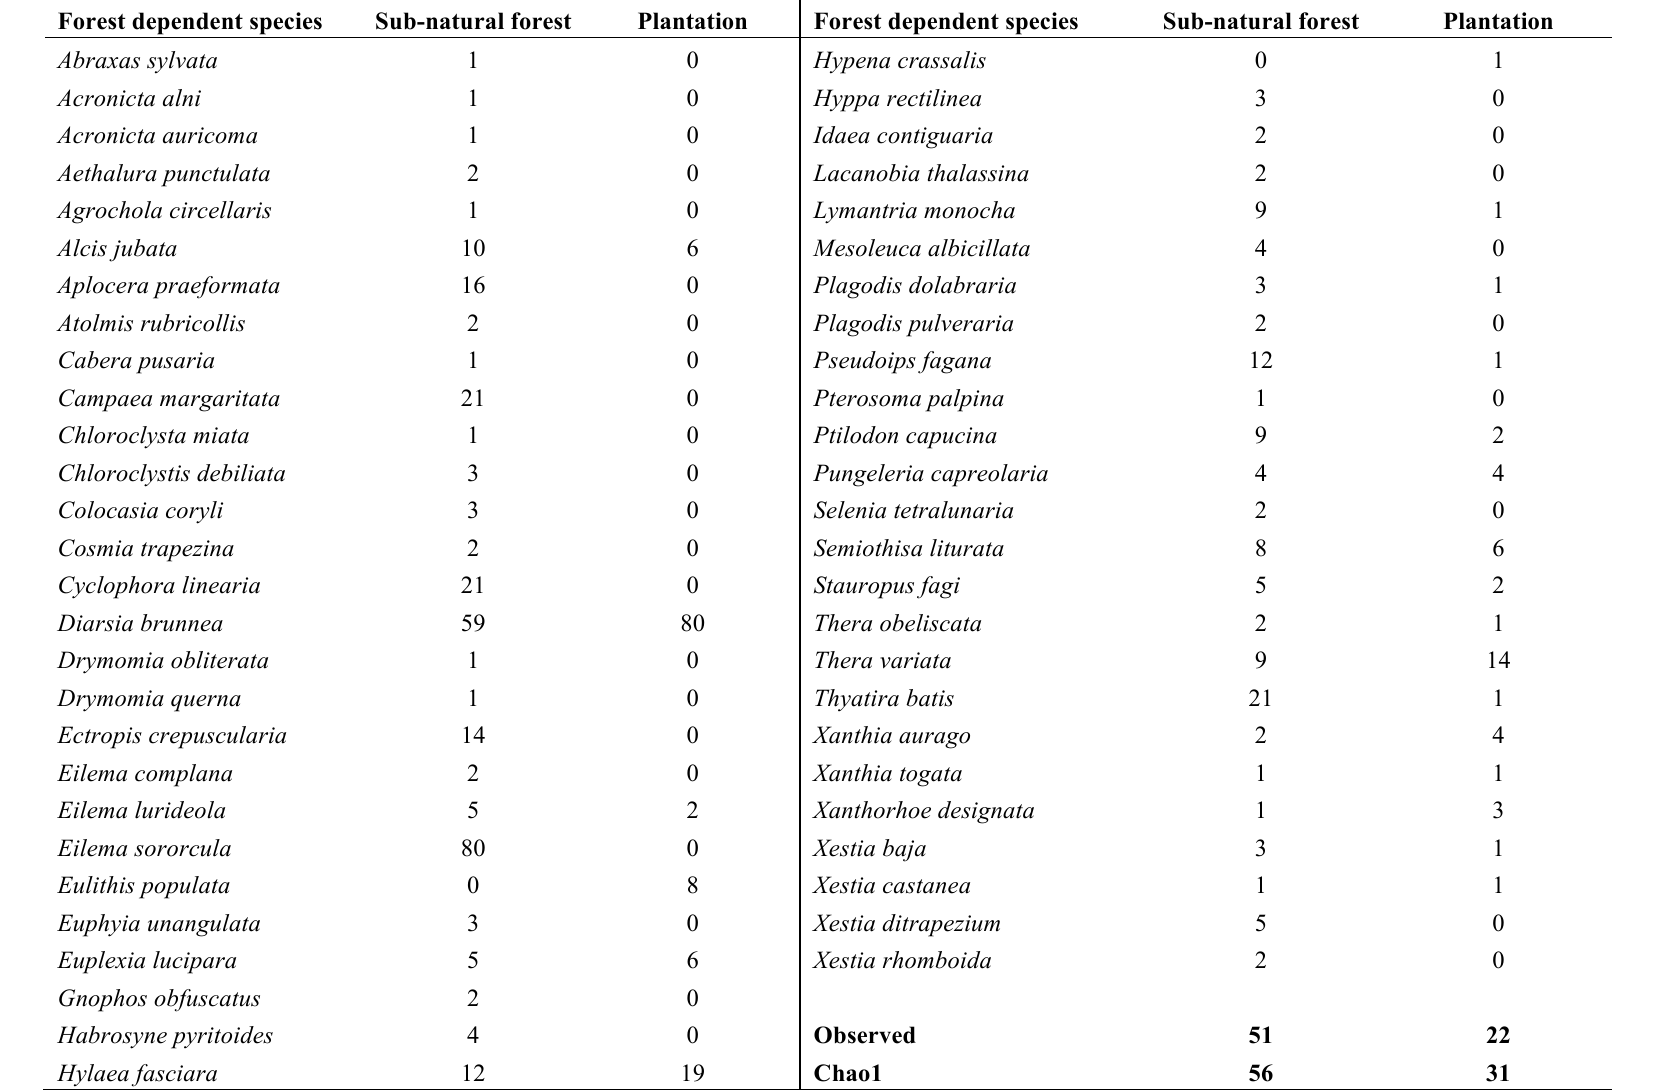
Table 4. List of forest dependent moth species and species indices. A list of non-forest dependent species collected is given in Appendix 2. Forest dependent species Sub-natural forest Plantation Forest dependent species Sub-natural forest Plantation Abraxas